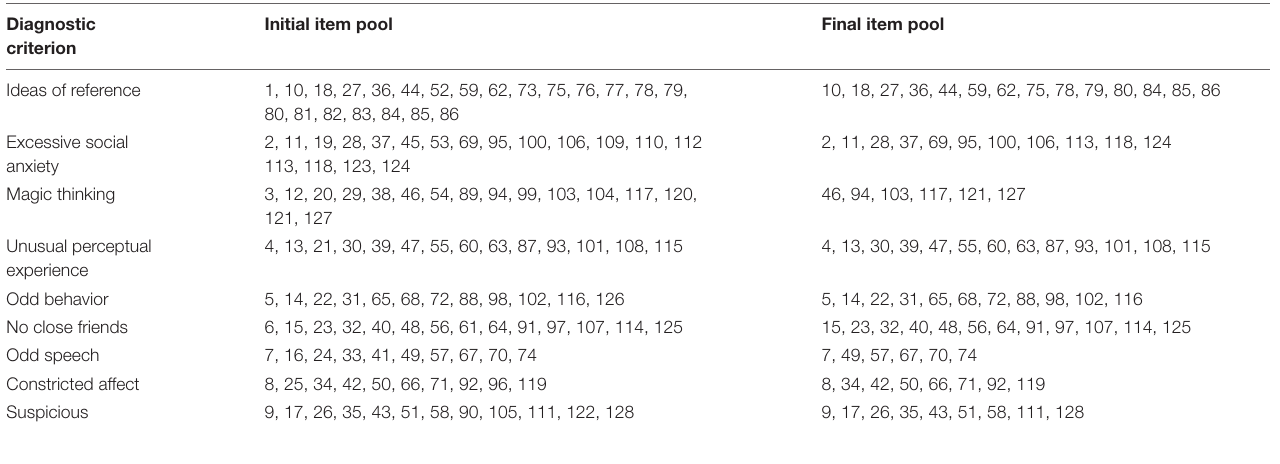
TABLE 5 | The distribution of items in each diagnostic criterion of SPD in